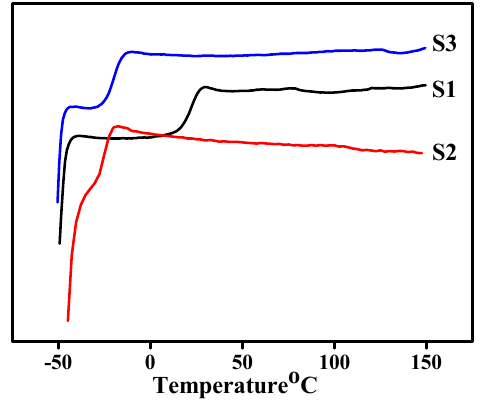
Figure 8. DSC curves of S1, S2 and S3.